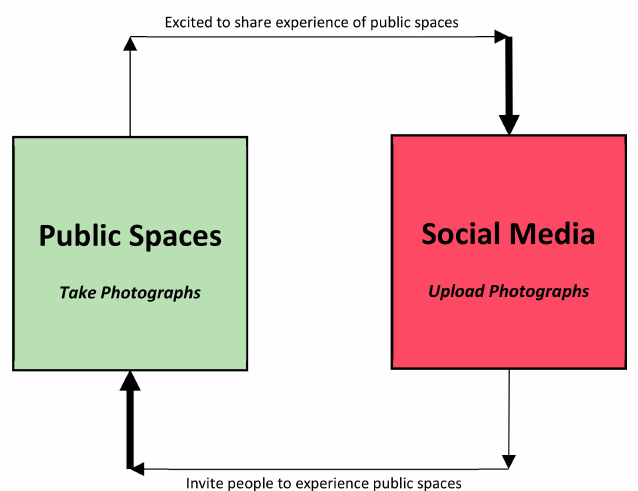
Figure 17. Social media and public spaces: feedback loop system. As people visit public spaces, many upload their photographs on social media websites. These shared photographs advertise, encourage, and invite other people to visit these spaces. When more people visit and upload photographs, social media invites more people to visit these spaces, making them more